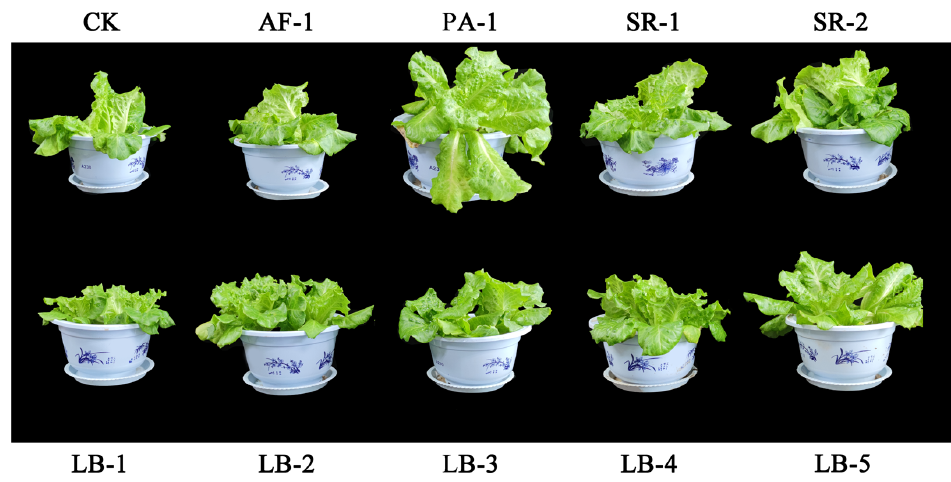
Figure 3. The growth of le(cid:308)uce in different treatments.